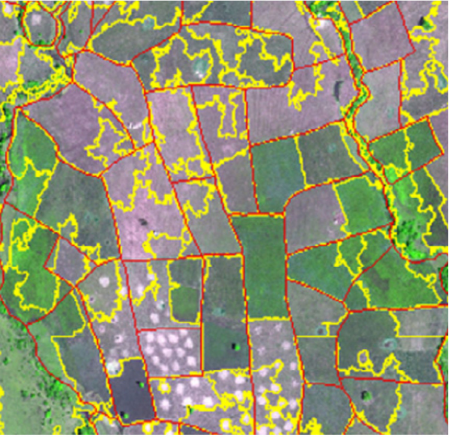
Figure 9. Wassie et al. [277] used open-source software to develop a workflow to extract smallholder parcel boundaries using HRSI in Ethiopia. Note: red = control boundaries; yellow =